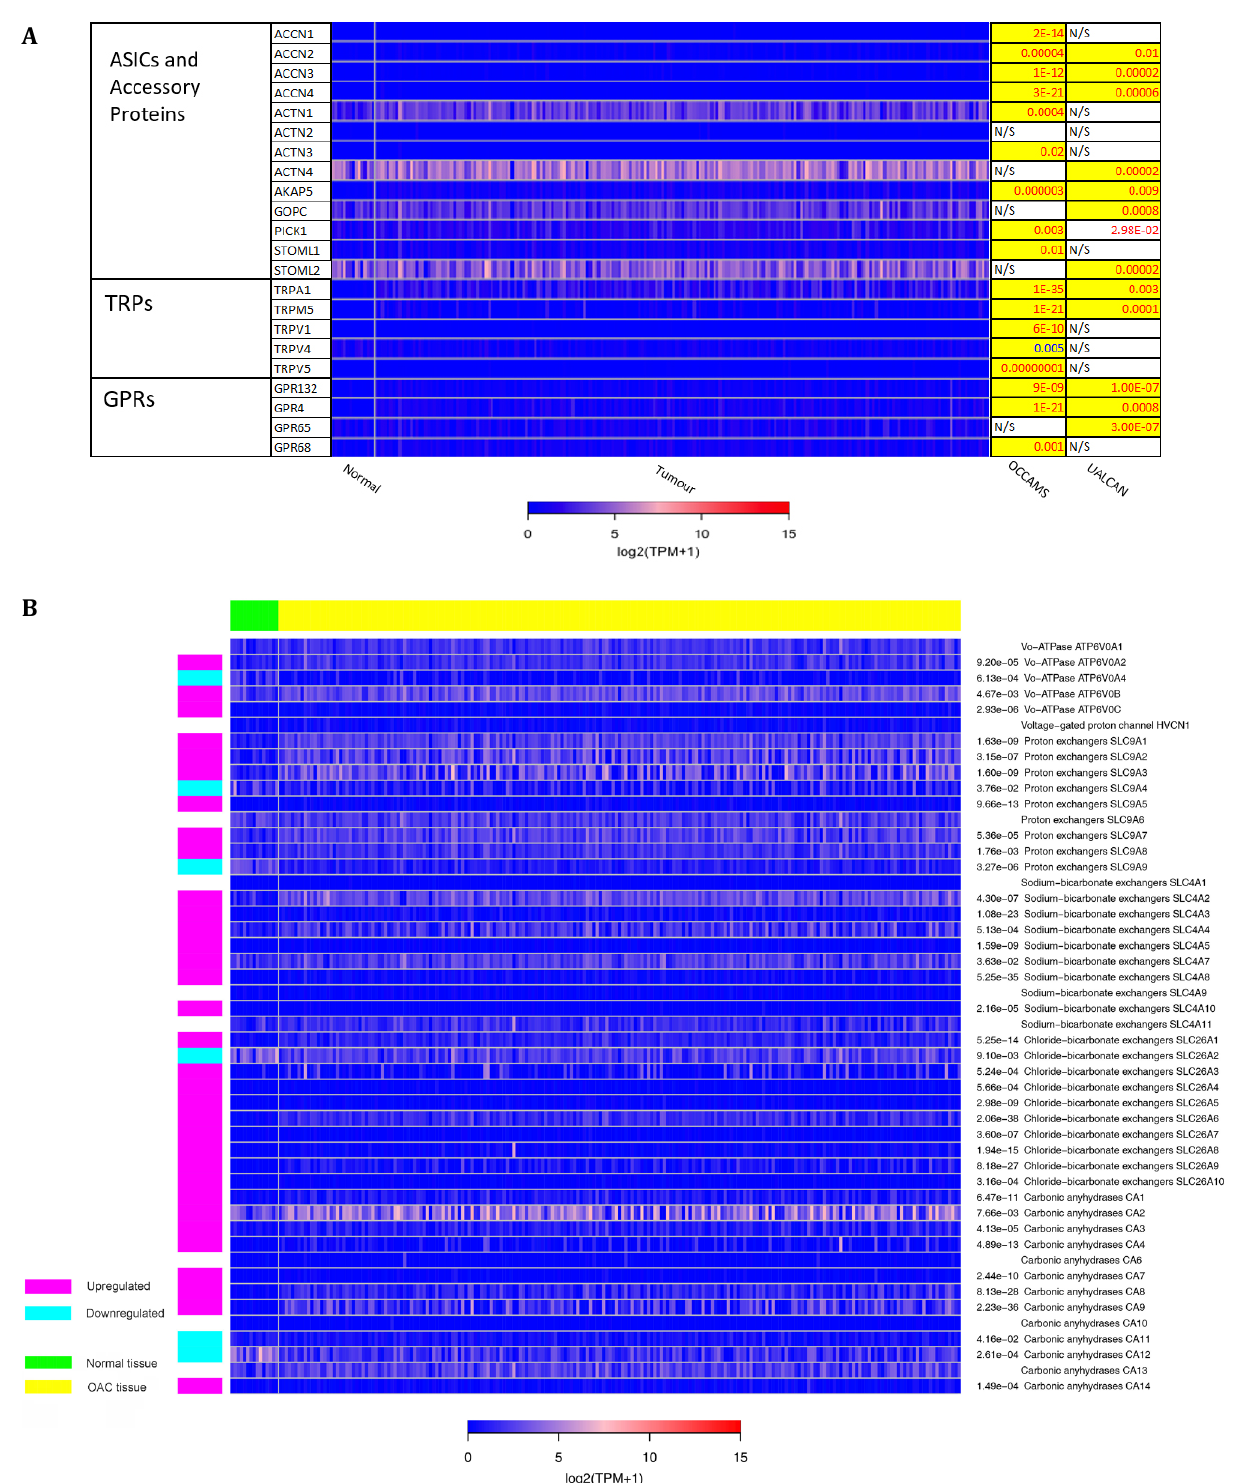
Figure 2. Expression in OAC of A) Acid-sensing channels, receptors and their accessory proteins; and B) proton-regulating proteins. Heat maps depicting the expression levels of genes encoding proteins involved in acid-sensing and proton homeostasis in OAC tumor versus normal tissue. The heat map shows expression data for patients from the OCCAMS dataset. The look-up table represents expression in TPM, with log2 (TPM + 1) scaling. The P -values for significant expression levels (significance was set at P < 0.05) from each dataset are listed on the right, with P -values in red font indicating upregulation, and P -values in blue font indicating downregulation, compared to normal tissue. The P -values highlighted in yellow were considered significant after adjustment for MOT. N/S indicates a non-significant change in expression levels in tumor versus normal tissue. GRPs: ground rubber particles; ACTN: actinin α; AKAP: A-kinase anchoring protein; GOPC: golgi-associated PDZ and coiled-coil motif-containing; PICK: protein interacting with C kinase; STOML: stomatin-like; NHE: Na-H exchange; NHX: Na + /H +